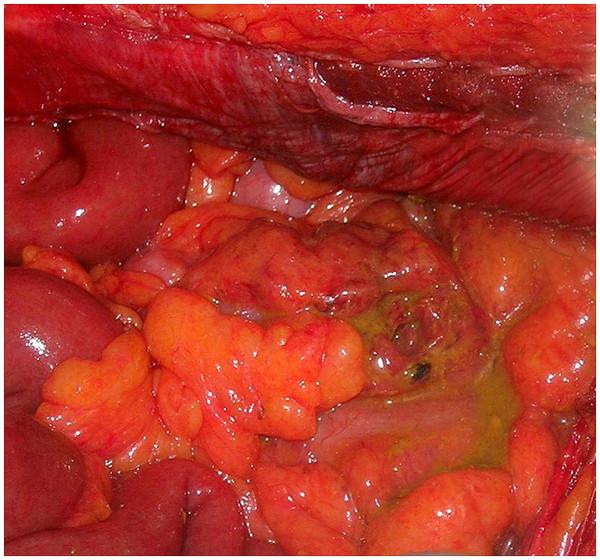
Fecal contamination.